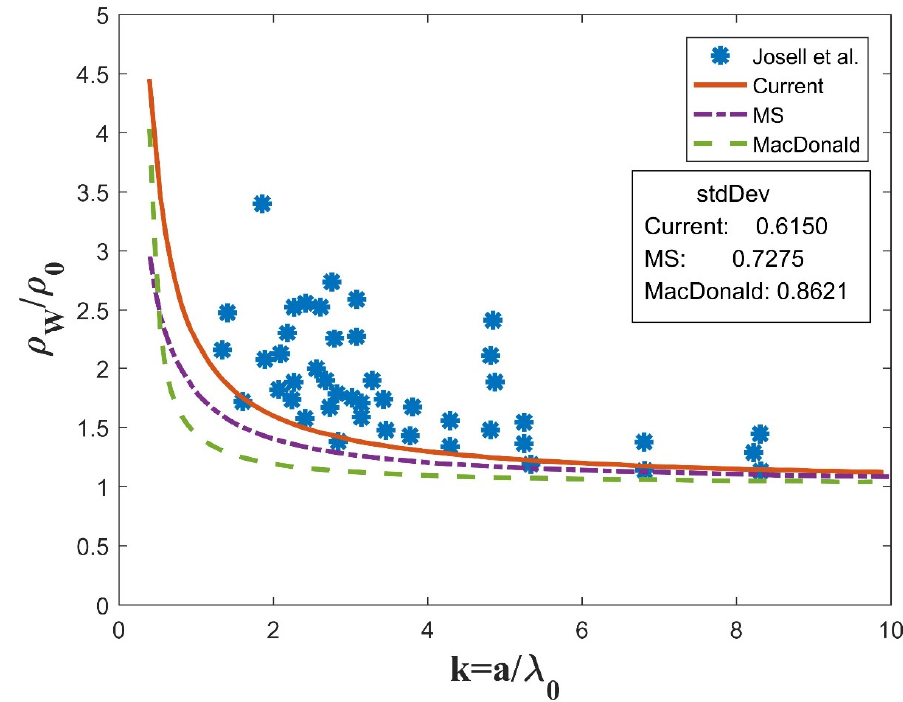
Figure 4. Comparison between numerical simulations and experiment data for Ag with parameters p = 0.5, R = 0.3, C =